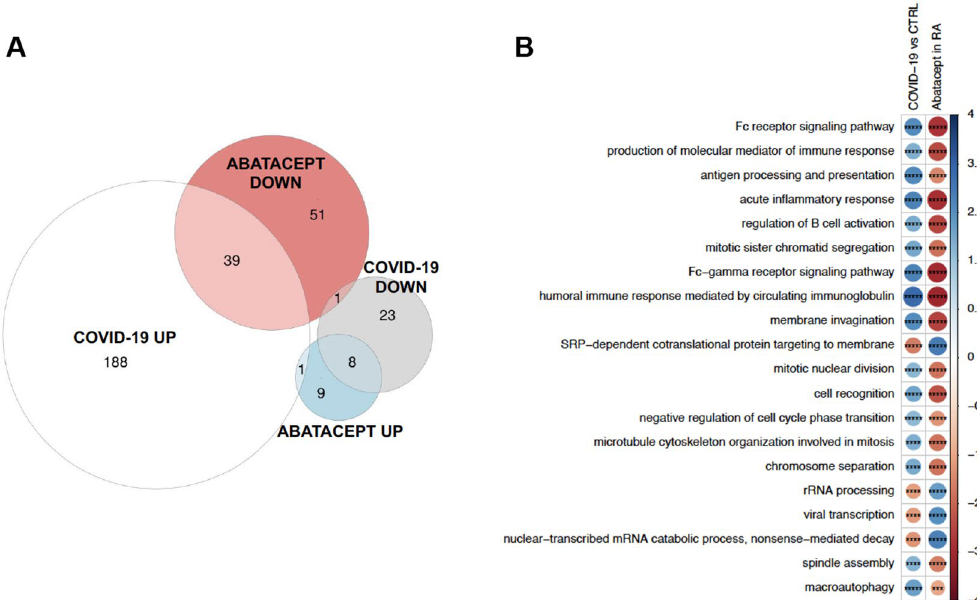
Figure 2. Biological processes modified by COVID-19 and by treatment with abatacept: early cohort. COVID- 19 associated processes represent processes dysregulated in COVID-19 patients compared to healthy controls in the early cohort. ( A ) Multiple Venn plot showing the biological processes significantly modified by each exposure (FDR < 0.05) and the resulting disjoint combinations. From the overlapping processes, 47 out of 49 (96%) were found to be modified antagonistically by abatacept while only 2 (4%) processes showed changes in the same direction. ( B ) 20 top biological pathways that show a higher level of antagonism between COVID- 19 exposure and treatment with abatacept. FDR-adjusted P-values from the two analyses were combined using Fisher’s method, and the resulting combined P-value are used here as a ranking measure of antagonism. Blue indicates upregulation and red downregulation of the pathway as measured by the GSEA Normalized Enrichment Score, which is also reflected in the circle size. FDR-corrected P-value levels are indicated as *<